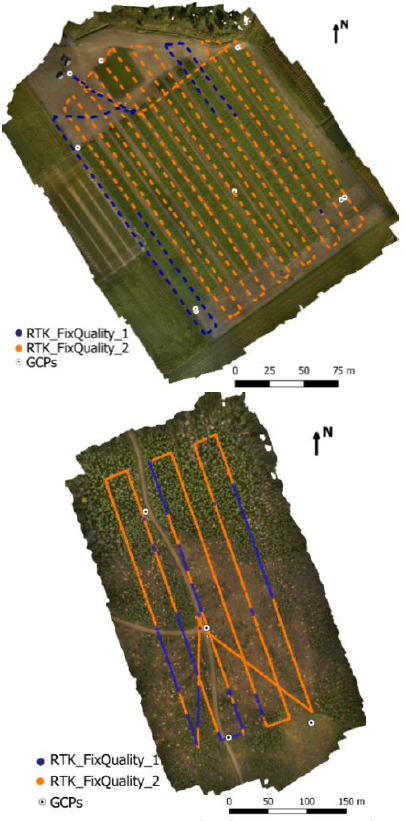
Figure 3. Test sites Jokioinen (top) and Hyytiälä (bottom) and ground control points. The background image are orthomosaics generated from the RGB images collected by the designed system.